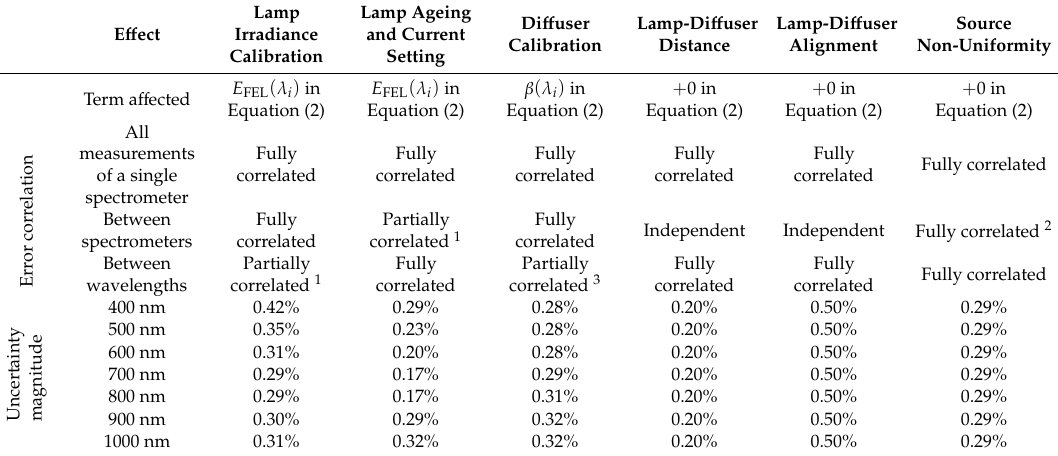
Table 1. Uncertainties associated with reference source